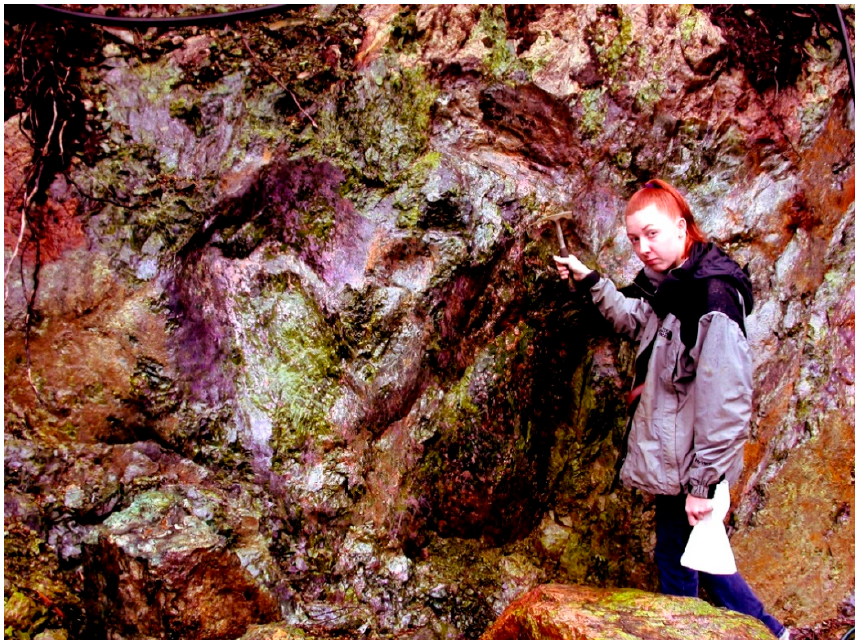
Figure 7. Outcrop-scale photograph of stichtite occurrence and abundance at Stichtite Hill, Tasmania, Australia. Stichtite (purple areas) constitute about 50% of this outcrop, with the balance being serpentine (shades of green) and pyroaurite (brownish-red). Geologist is 1.6 m tall.